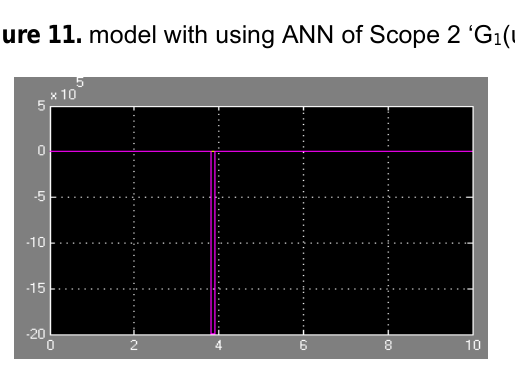
Figure 15. model with using ANN of Scope 2 ‘G 3 (u)’